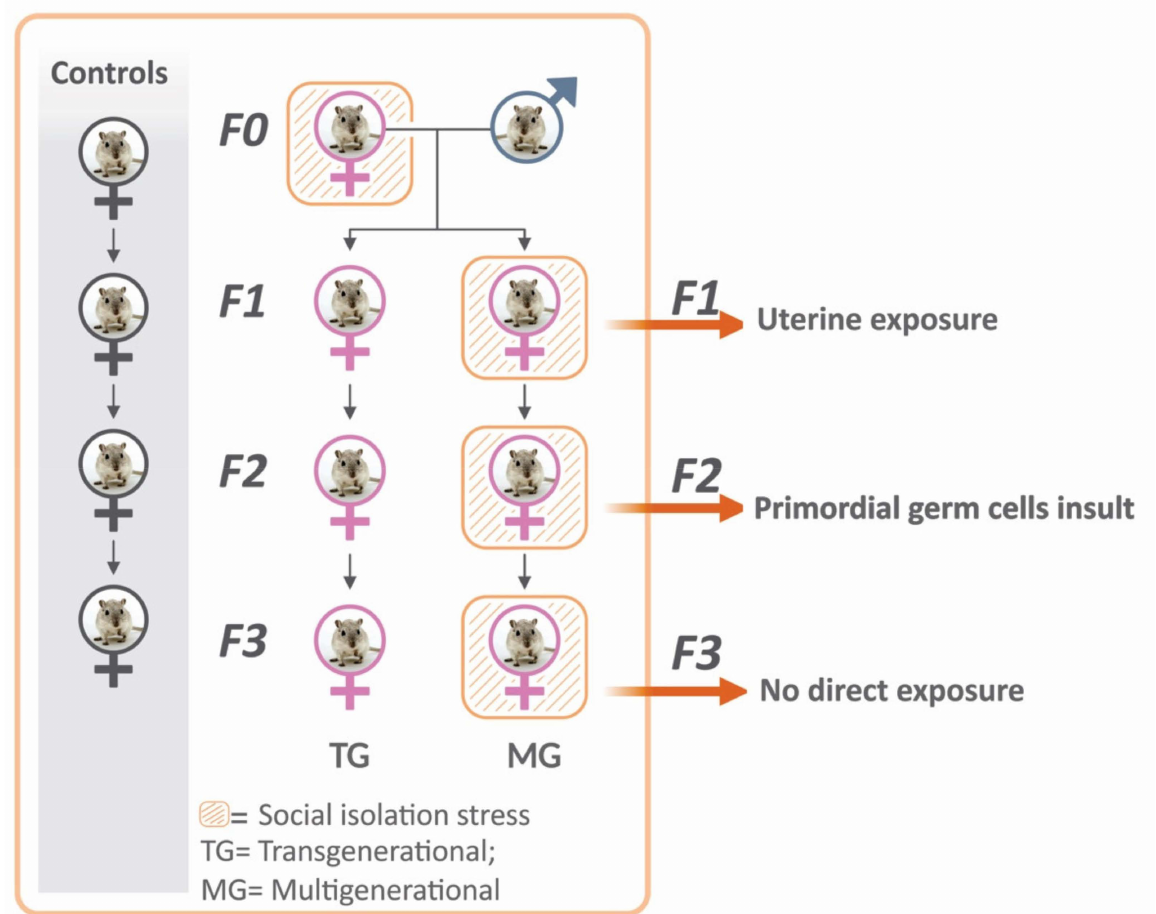
Figure 1. Social isolation stress design. Flow chart illustrating the SIS experimental design. F0 rats were subjected to SIS, and their filial generation F1 was split into TG and MG groups. In the TG group, stress was only implemented in the parental F0 generation, while each parental and offspring generation was exposed in the MG group. F0–F3 generations of non-stressed rats served as controls. In the TG lineage, exposing the gestating female F0 generation to SIS implies that only the F1 fetuses experience direct uterine exposure to stress, and the F2 generation’s exposure to stress is through their mother’s primordial germ cells (F1 generation’s germ cells). Therefore, the F3 generation of the TG lineage is the first unexposed generation, considered a true transgenerational inheritance. In the MG lineage, all generations of offspring experience both direct and cumulative uterine exposure to stress through the maternal primordial germ cells. TG = transgenerational; MG = multigenerational; F = filial